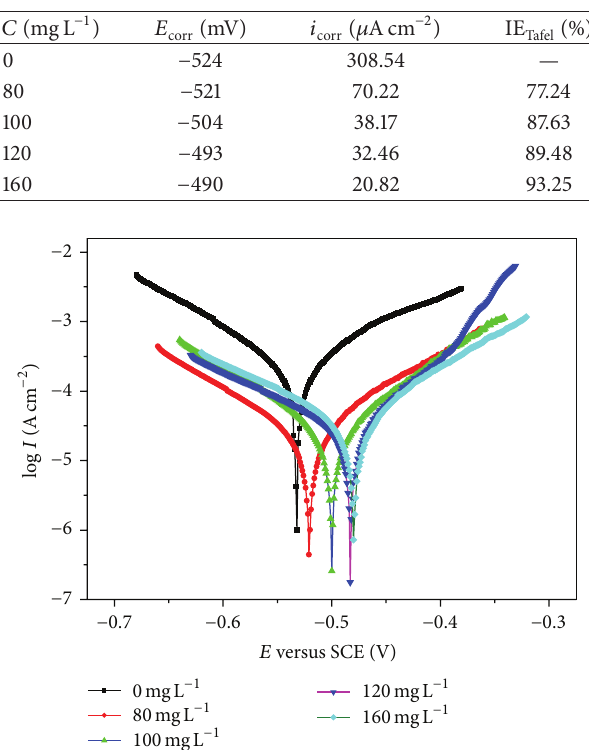
Table 2: The polarization parameters and corresponding inhibition efficiency for carbon steel in 0.5 M HCl in the absence and presence of different concentrations of EAPP at 300 K.